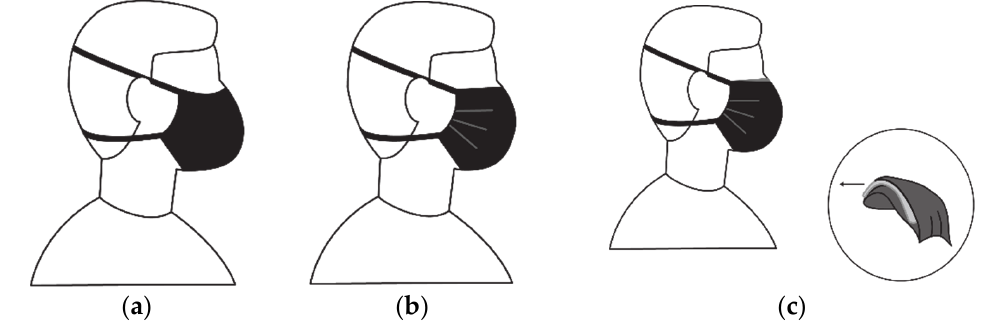
Figure 1. Illustration of mask styles. ( a ) Shaped mask (style S); ( b ) pleated mask (style E); ( c ) mask with filter (style EF).